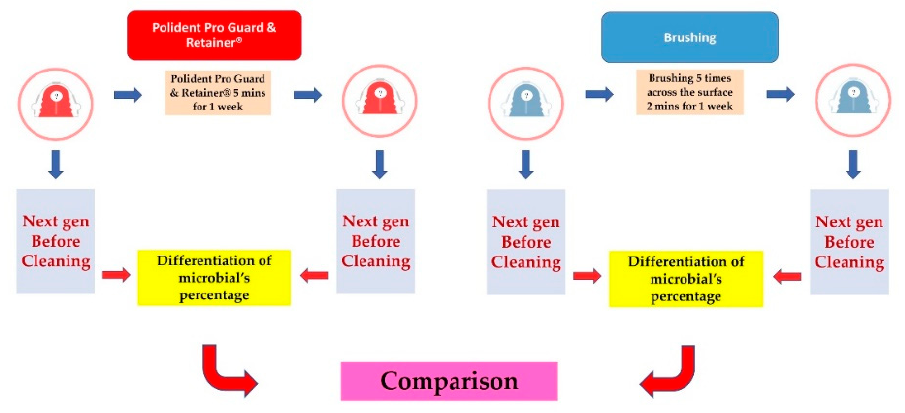
Figure 1. Study Figure 1. Study design.